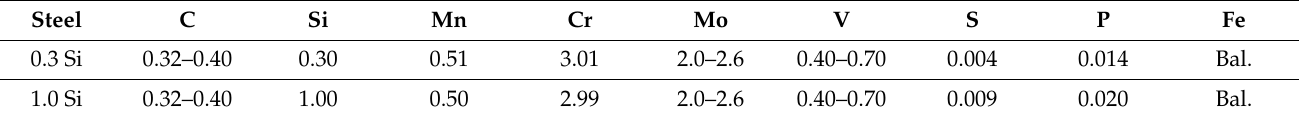
Table 1. Chemical composition of tested steel (mass